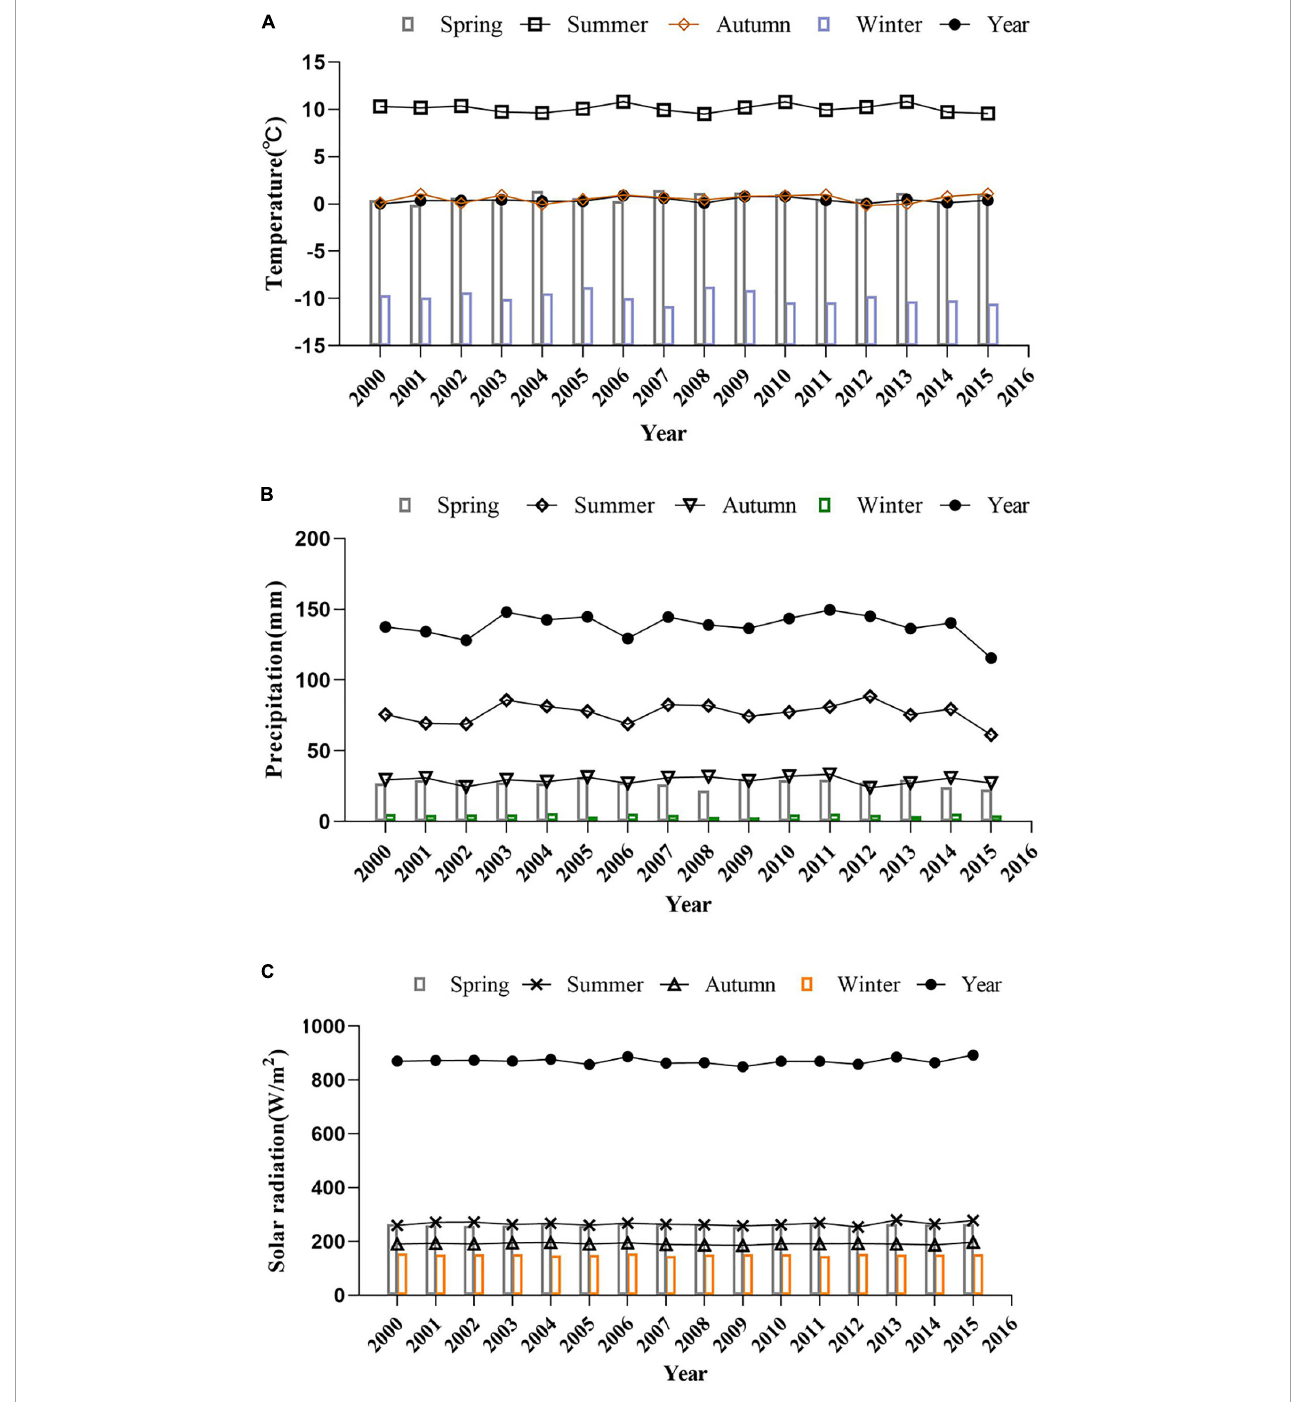
FIGURE5 The change trend of (A) temperature, (B) precipitation, and (C) solar radiation from 2000 to 2015.